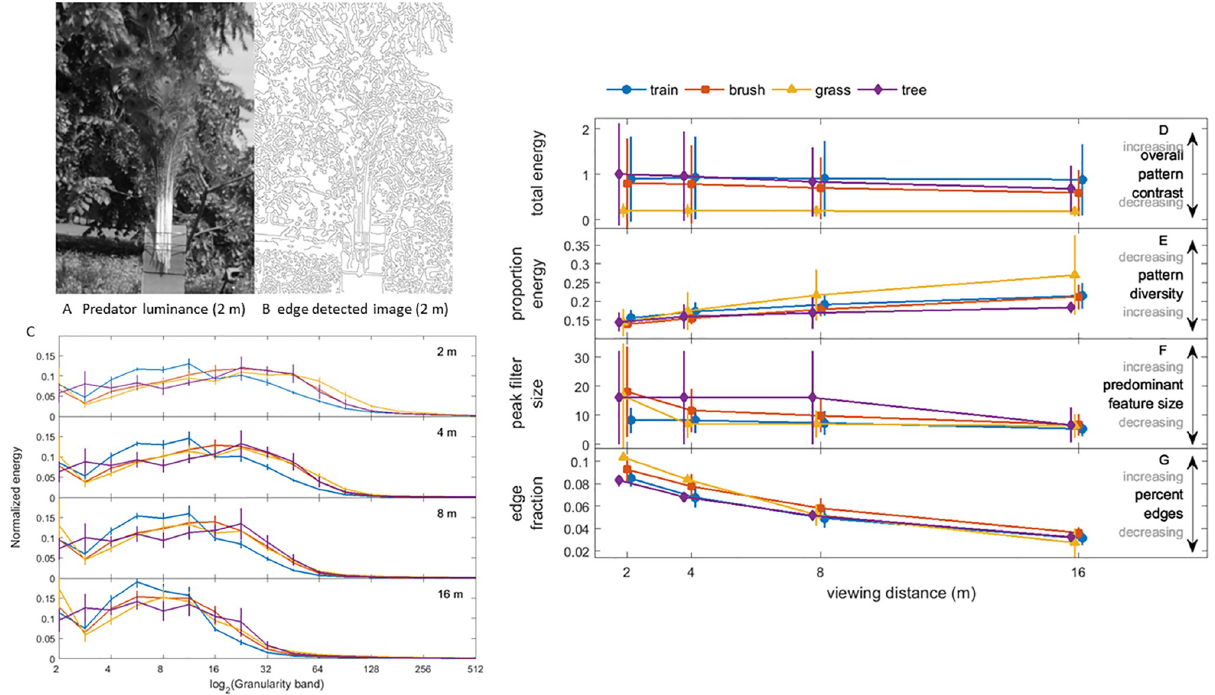
Fig 10. Texture analysis of the model peacock train photographed against various vegetation backgrounds. (A) Image based on dichromatic mammalian predator luminance channel and (B) result of edge detection on the luminance image. (C) Granularity spectrum for the model peacock train and three different regions of vegetation in the background vs viewing distance. (D) Total spectral energy summed over the granularity spectrum, which gives a measure of overall pattern contrast. (E) Proportional energy, a measure of how much the dominant feature size dominates and hence pattern diversity; (F) spatial frequency at peak spectral energy, which is inversely proportional to the predominant feature size; (G) edge fraction, the proportion of the image corresponding to edges. Data are grand means for all model train images and error bars show 95% CI.